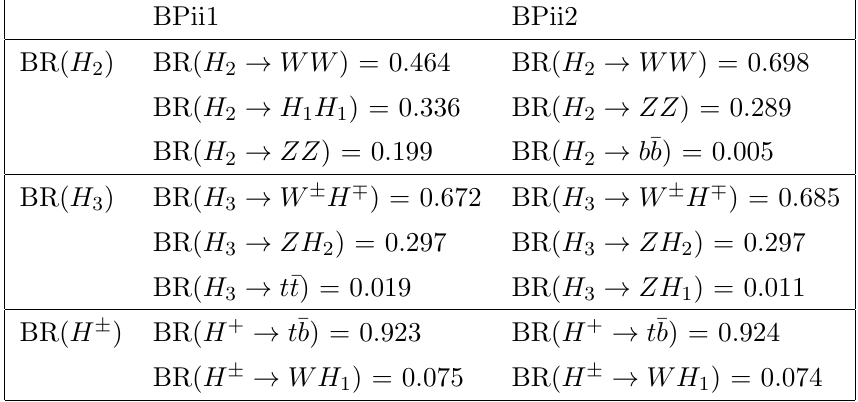
Table 5 . The dominant branching ratios of the BPii1 and BPii2 Higgs